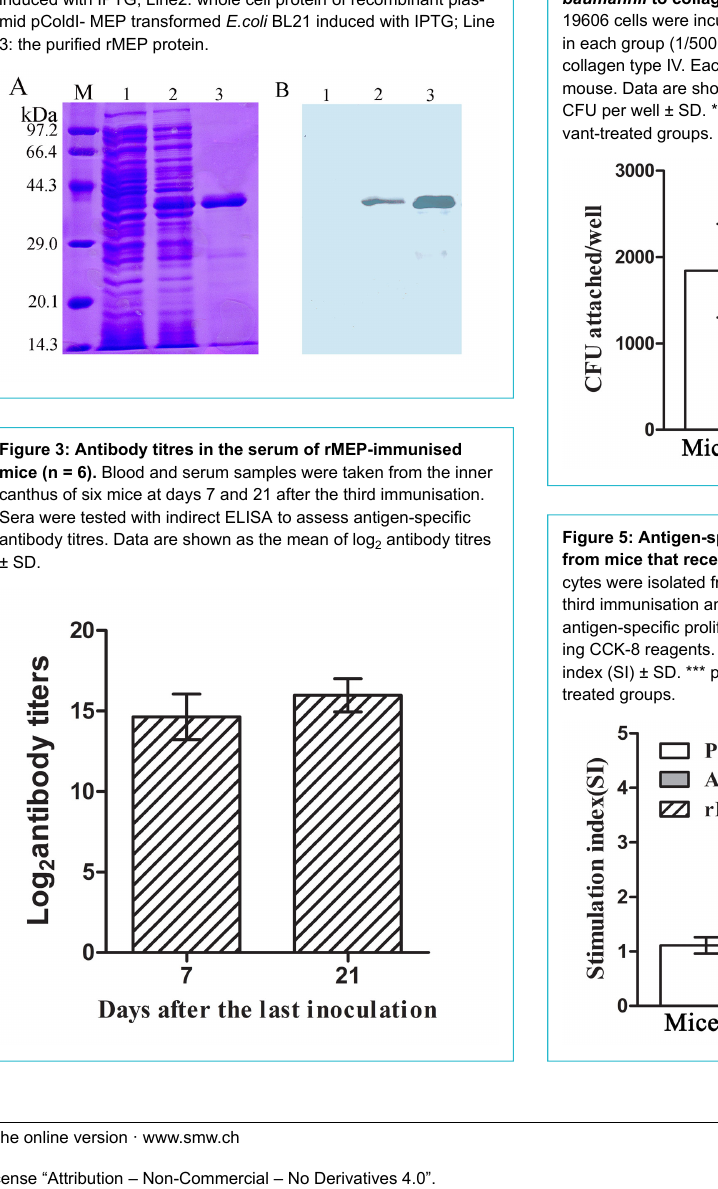
Figure 2: SDS-PAGE and Western-blot analysis of the expres- sion and purification of rMEP. E. coli BL21 transformed with the recombinant plasmid pColdI- MEP or the empty vector pColdI were cultured in LB medium and induced with 1mM IPTG. The re- combinant protein was purified through nickel affinity chromatogra- phy. The expression and purification of the recombinant protein were analy ed by using SDS-PAGE and Western-blot. (A) 12% SDS-PAGE; (B) Western blot analysis of the rMEP using an- ti-6×His antibody. Line M: protein molecular weight marker; Line1: whole cell protein of empty vector pColdI transformed E.coli BL21 induced with IPTG; Line2: whole cell protein of recombinant plas- mid pColdI- MEP transformed E.coli BL21 induced with IPTG; Line